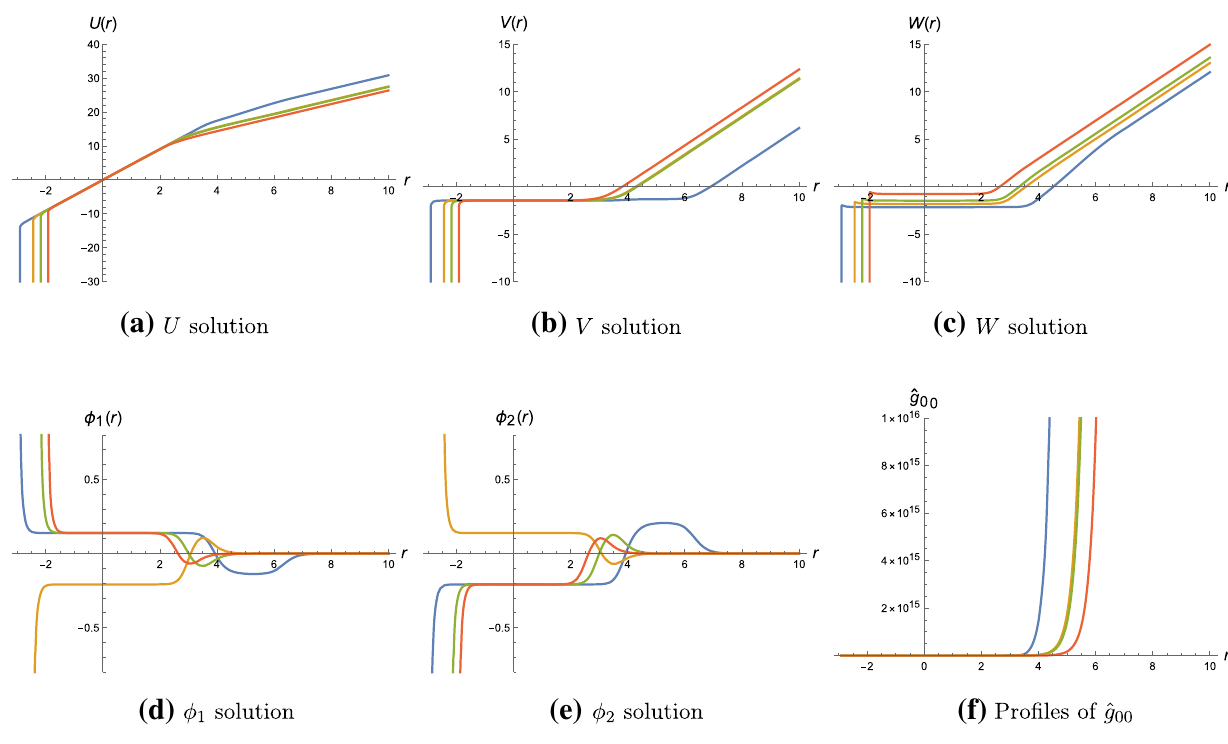
Fig. 15 RG flows from the N = 4 AdS 7 critical point to the AdS 3 × H 2 × R 2 fixed points and curved domain walls for SO ( 2 ) × SO ( 2 ) twist in SO ( 5 ) gauge group. The blue, orange, green and red curves refer to ( z 1 , z 2 ) = ( 1 , − 0 . 5 ),( − 1 , 1 ),( 1 , − 2 ),( − 8 , 1 ) ,